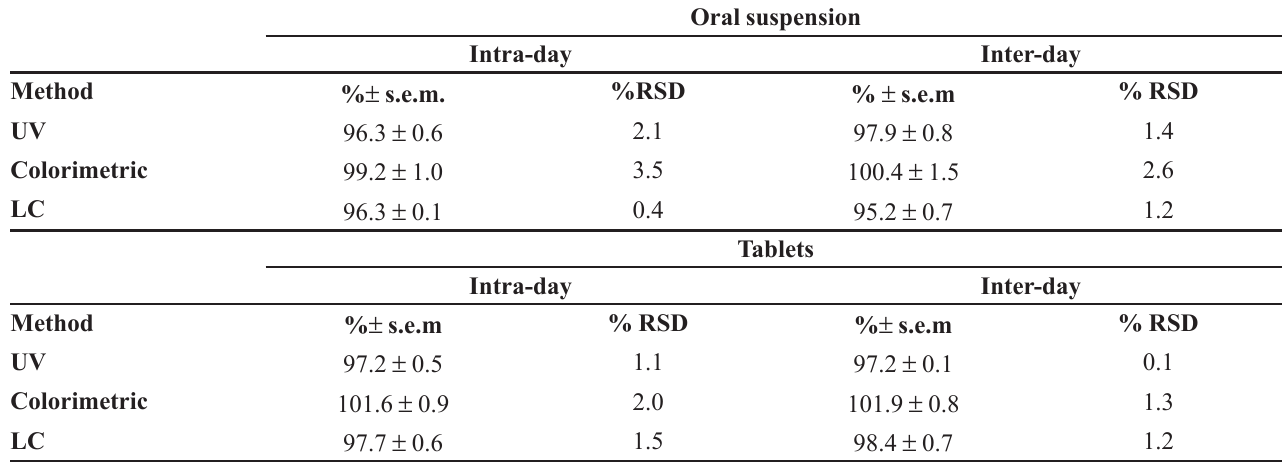
TABLE II - Precision of the evaluated methods for deflazacort determination